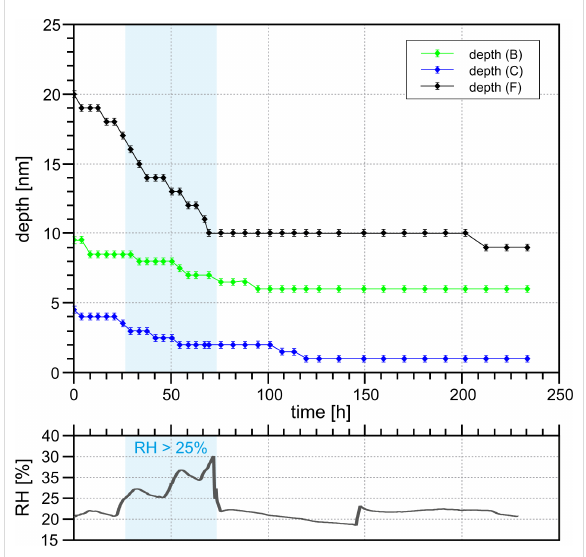
Figure 3: Maximum depth of the observed holes over time. The poking holes to which the letters correspond is displayed in Figure 2 a). The blue highlighted area shows the second time period with RH > 25%. Only holes (B,C,F) are displayed, the full graph is displayed in Sup- porting Information File